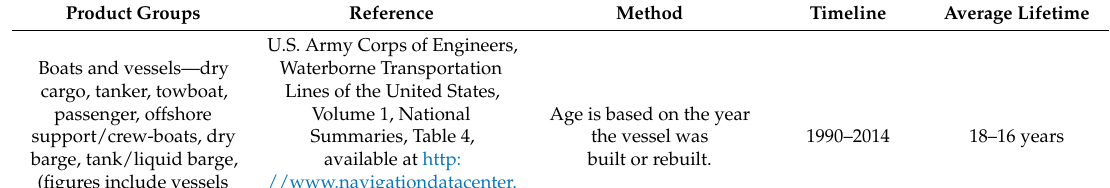
Table A3. Average in-use lifetime per unit in the automotive sector in the United States.